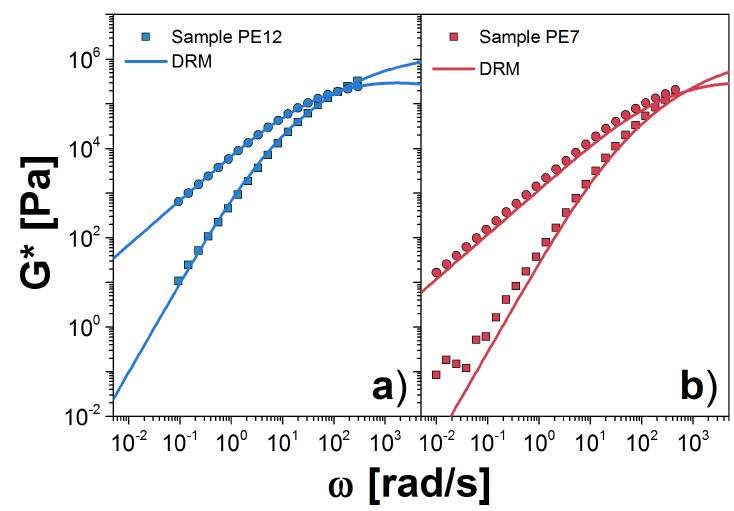
Figure 4. Dynamic moduli for PE samples: ( a ) PE12; and ( b ) PE7 at 190 ◦ C (solid symbols). Our prediction using the DRM is represented by solid lines. The corresponding values for G 0 are shown in Table 2. In panel ( b ), we used the G 0